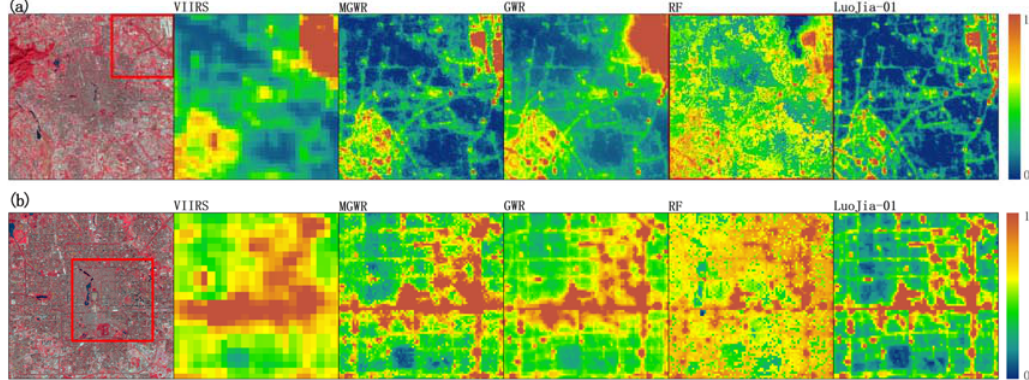
Figure 5. Spatial texture contrast maps of the downscaled NTL data predicted by the three methods. The red boxes indicate the location of the local area within the entire study area. ( a ) Beijing Capital International Airport; ( b ) part of Central Beijing. Study period: September 2018.